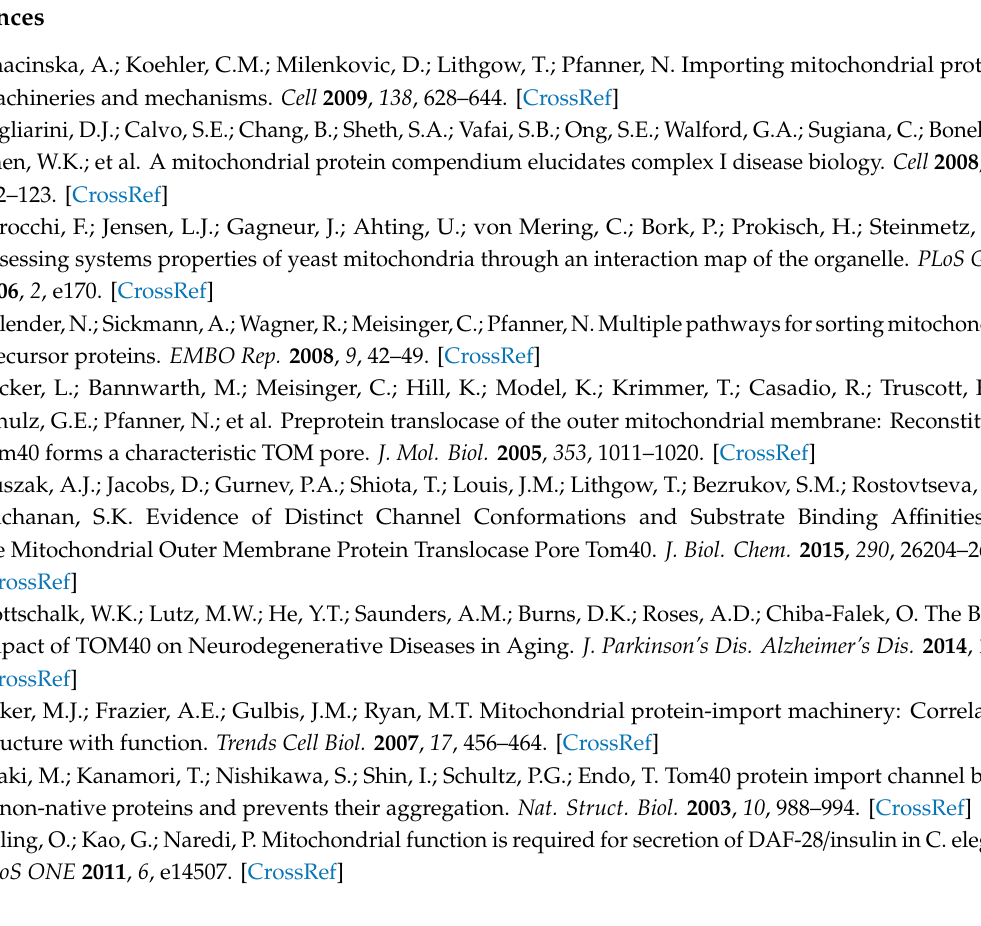
Figure S1. Disease-free survival and overall survival curves for patients with epithelial ovarian cancer (EOC) according to FIGO stage, cell type, and tumor grade. FIGO, The International Federation of Gynecology and Obstetrics, Figure S2. The growth rate for TOM40 stably overexpressed cells, Figure S3. The measurement of intracellular dehydrogenase activity according to TOM40 expression, Figure S4. Cytochrome oxidase activity is not correlated with TOM40 expression in various cell lines, Figure S5. Five subunits of total OXPHOS are slightly or not changed according to TOM40 expression, Figure S6. The intracellular reactive oxygen species increase in TOM40 knockdown cells comparing with sh-control expressed cells, Figure S7. TOM40 expression negatively correlates with AMPK activity in OVCA-429 cells, Figure S8. The protein levels of TOM complex subunits TOM22 and TOM20 decrease with TOM40 knockdown in epithelial ovarian cancer (EOC) cell lines, Figure S9. The molecular mechanism by which TOM40 regulates the expression of other TOM complex subunits has not been determined, Figure S10. TOM40 knockdown does not promote the translocation of several mitochondrial proteins to the mitochondria, Figure S11. Original Western blots of Figure 1B, Figure S12. Original Western blots of Figure 2A, Figure S13. Original Western blots of Figure 6A, Figure S14. Original Western blots of Figure 6B, Figure S15. Original Western blots of Figure 6E, Figure S16. Original Western blots of Figure S2, Figure S17. Original Western blots of Figure S5, Figure S18. Original Western blots of Figure S7, Figure S19. Original Western blots of Figure S8A, Figure S20. Original Western blots of Figure S8C, Figure S21. Original Western blots of Figure S9A, Figure S22. Original Western blots of Figure S9B, Figure S23. Original Western blots of Figure